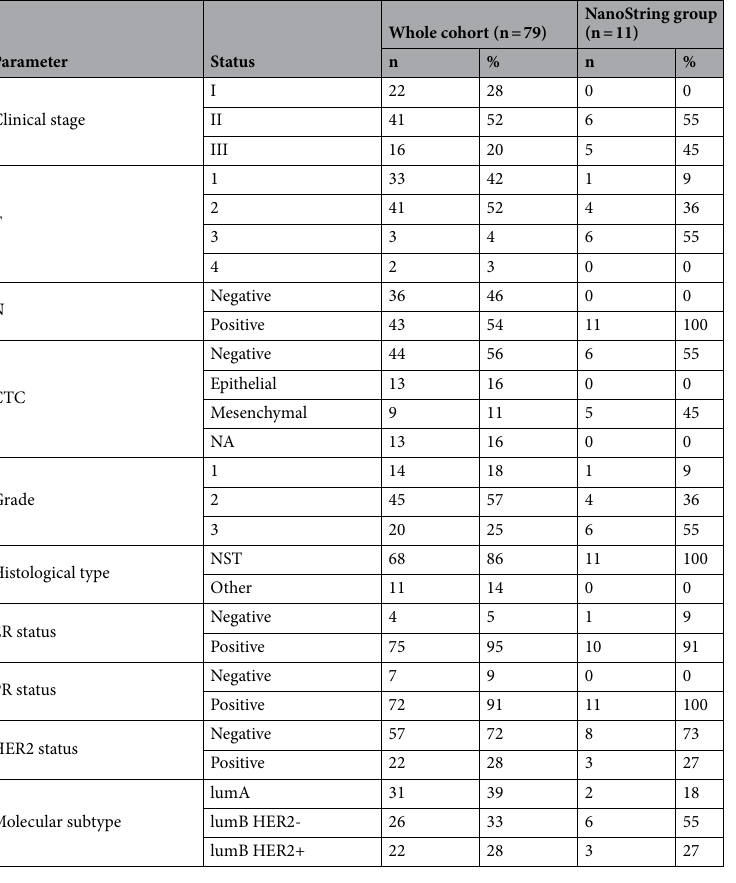
Table 1. Clinicopathological characteristics of the